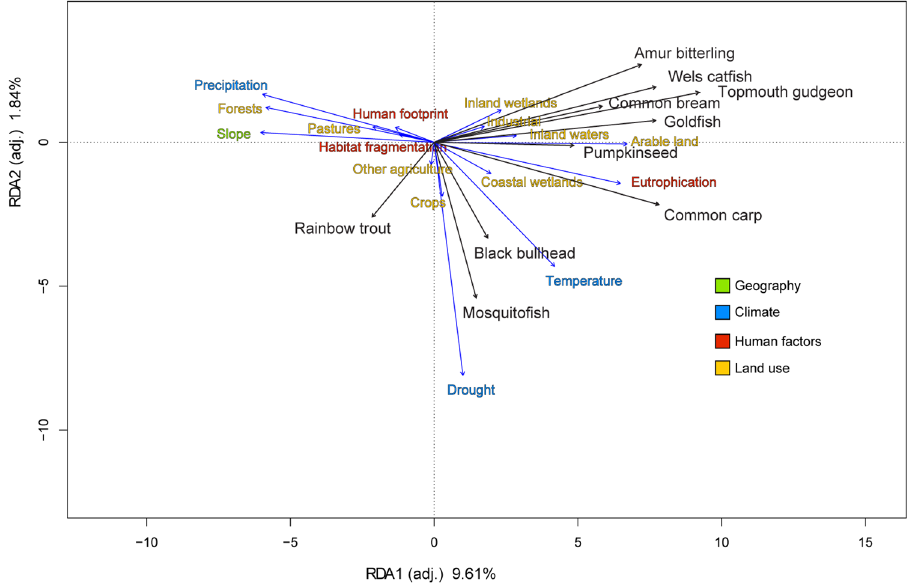
Figure 6. Biplot of RDA results, showing the effect of geography, climate, human factors and land use drivers on the distribution of the top 10 invasive freshwater fish species in Italy. Driver names in different colors identify different invasion drivers groups (see legend). The main axis (RDA1, horizontal) explains 9.61% of the variance (F = 432.56; P < 0.01), while the secondary axis (RDA2, vertical) explains 1.84% of the variance (F = 83.06; P < 0.01). Some variables close to origin (i.e. with negligible effects) were removed to improve